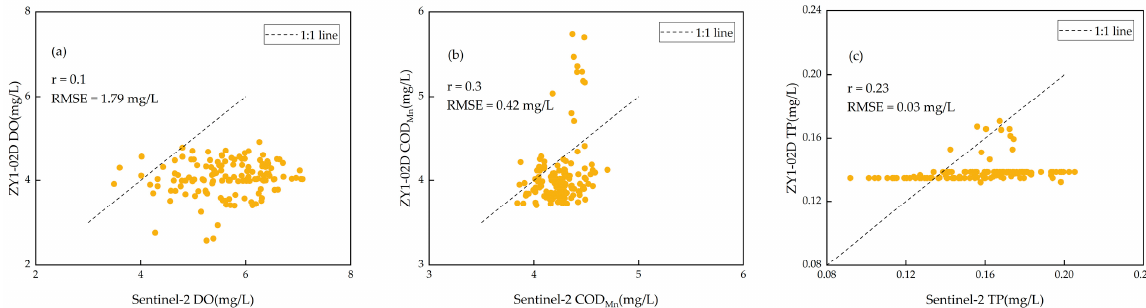
Figure 18. Agreement analyses among DO ( a ), COD Mn ( b ), and TP ( c ) derived from ZY1-02D and Sentinel-2 images.